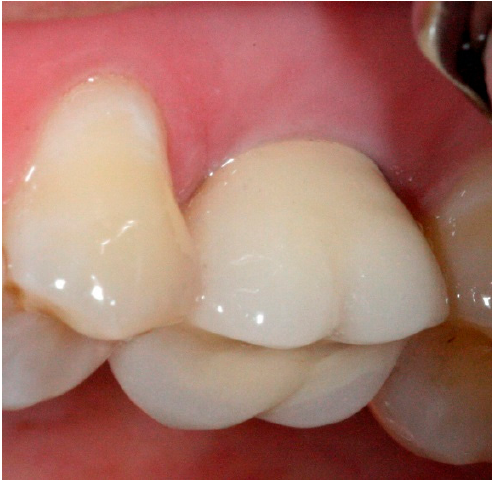
Figure 12. Posterior definitive crown cemented over definitive implant abutment.